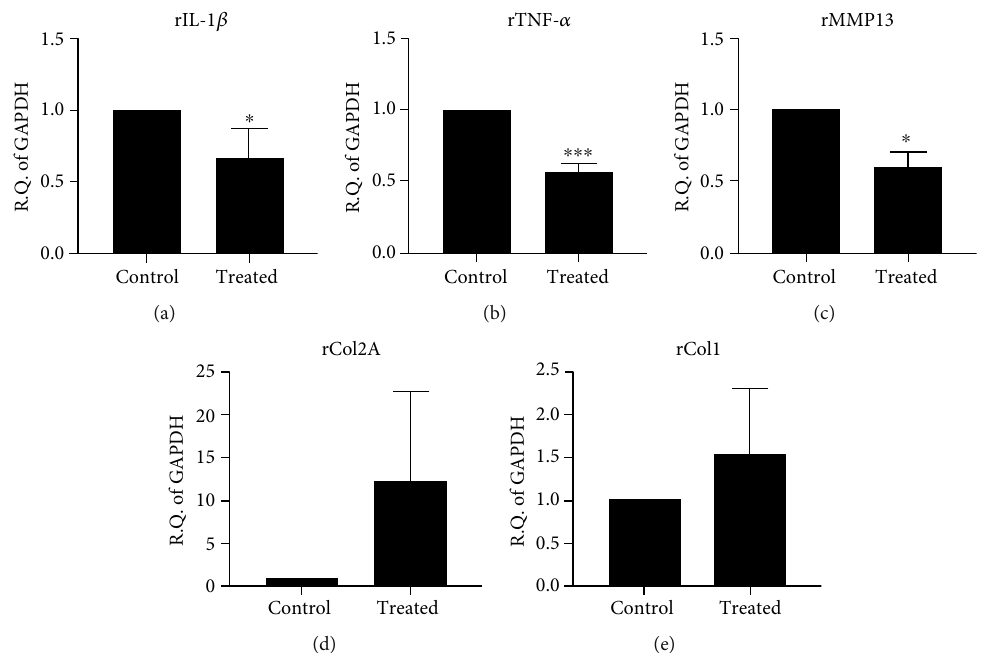
Figure 12: The qRT-PCR of in fl ammation, catabolic, and cartilage matrix gene expressions in the cartilage with or without transplanted chondrocytes ( n = 3 ). (a, b) The in fl ammatory cytokines, rIL-1 β (a) and rTNF- α (b), were illustrated. The in fl ammatory cytokines decreased expression after cell transplantation. (c) Catabolic matrix gene expression of rMMP13 . The expression of the catabolic gene decreased expression after cell transplantation. (d) Gene expression of cartilage matrix of type 2 collagen [ rCOL2A ]. The expression of type 2 collagen was not di ff erent between control and treated groups. (e) Gene expression of fi brocartilage marker (type 1 collagen [ rCOL1 ]). The expression of type 1 collagen was not di ff erent between control and treated groups. ∗ p < 0 : 05 , ∗∗∗ p < 0 : 001 . Statistical analyses between both groups were calculated with Mann – Whitney U